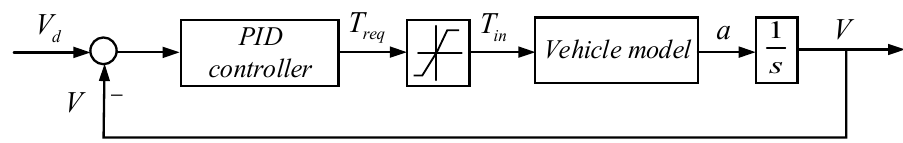
Figure 5. The longitudinal driver model.